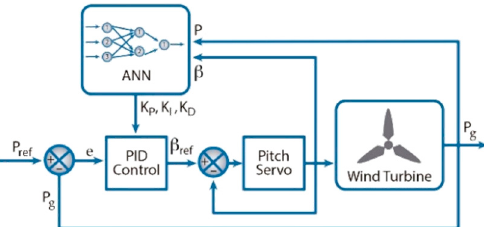
Figure 19. A PID controller is used to regulate the pitch angle and perform the MPPT; an ANN is used to adapt the PID gains in any state of the system [80].